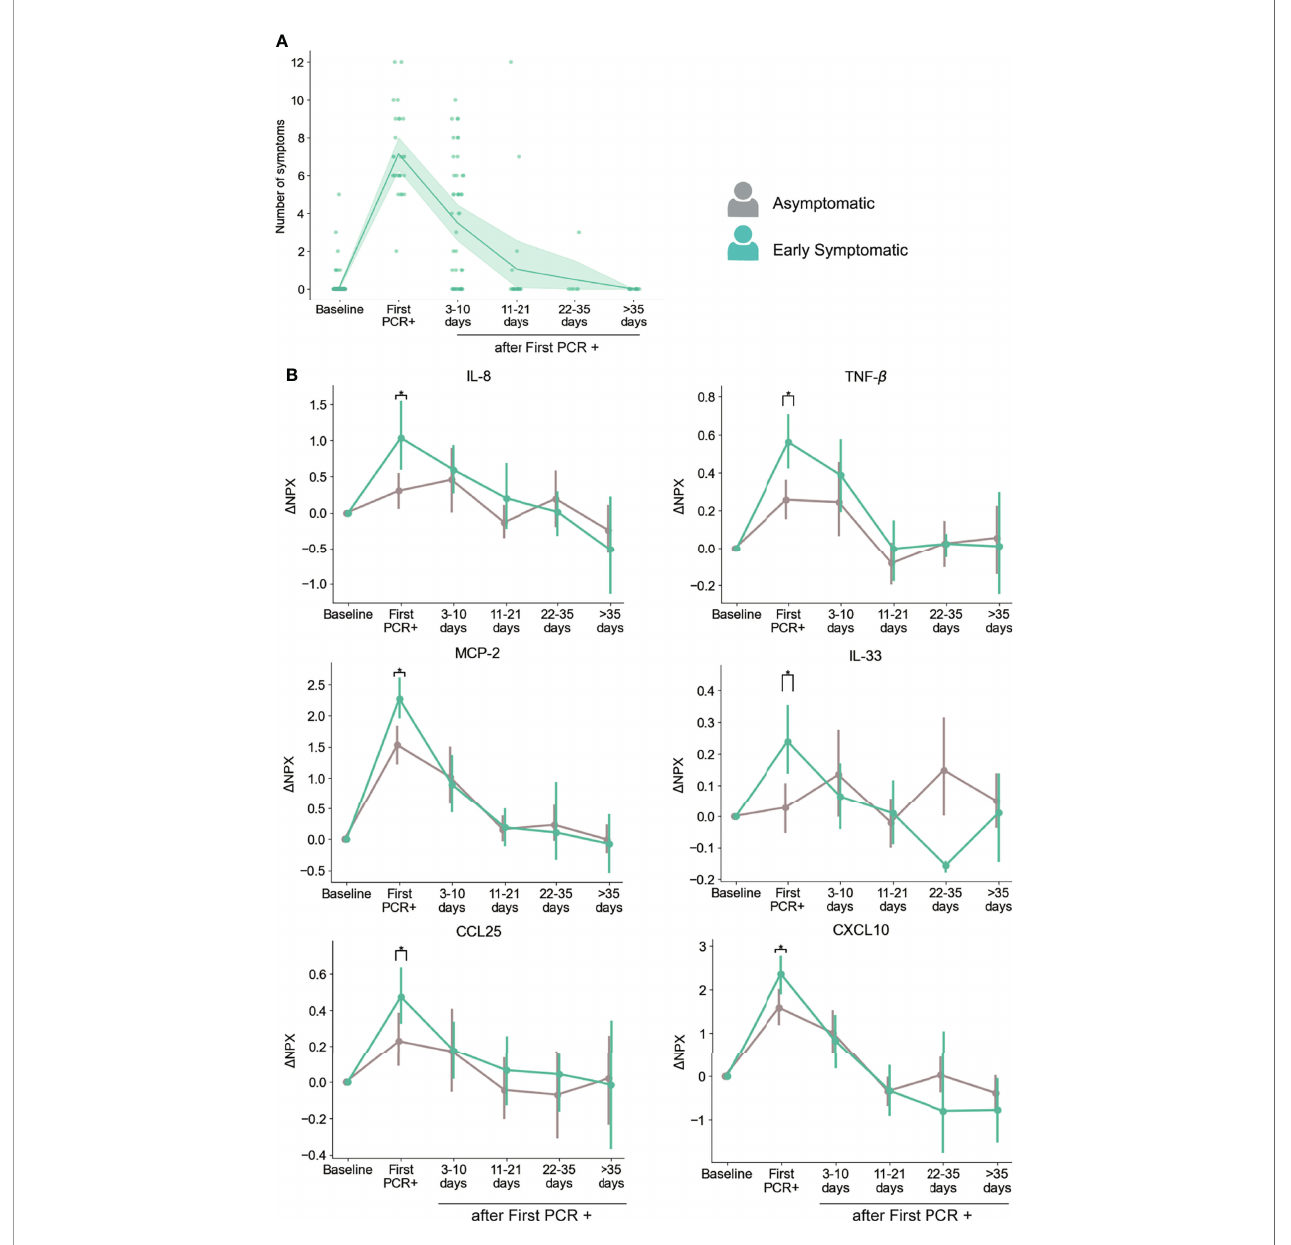
FIGURE 4 | Dynamics of serum markers with higher upregulation in Early Symptomatic participants (symptoms reported at First PCR+) than in Asymptomatic participants. (A) Temporal distribution of the number symptoms in Early Symptomatic participants. (B) Representative markers that are signi fi cantly upregulated in Early Symptomatic in comparison to Asymptomatic group of participants. Mean and 95% CI are indicated. *p <